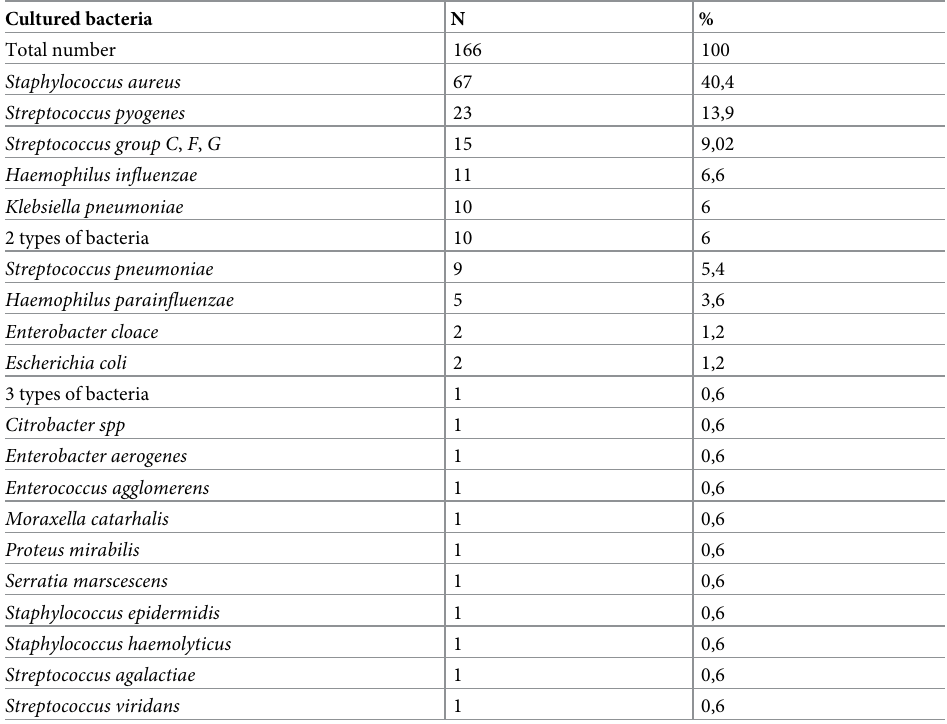
Table 1. Cultured bacteria identified in upper respiratory tract swab